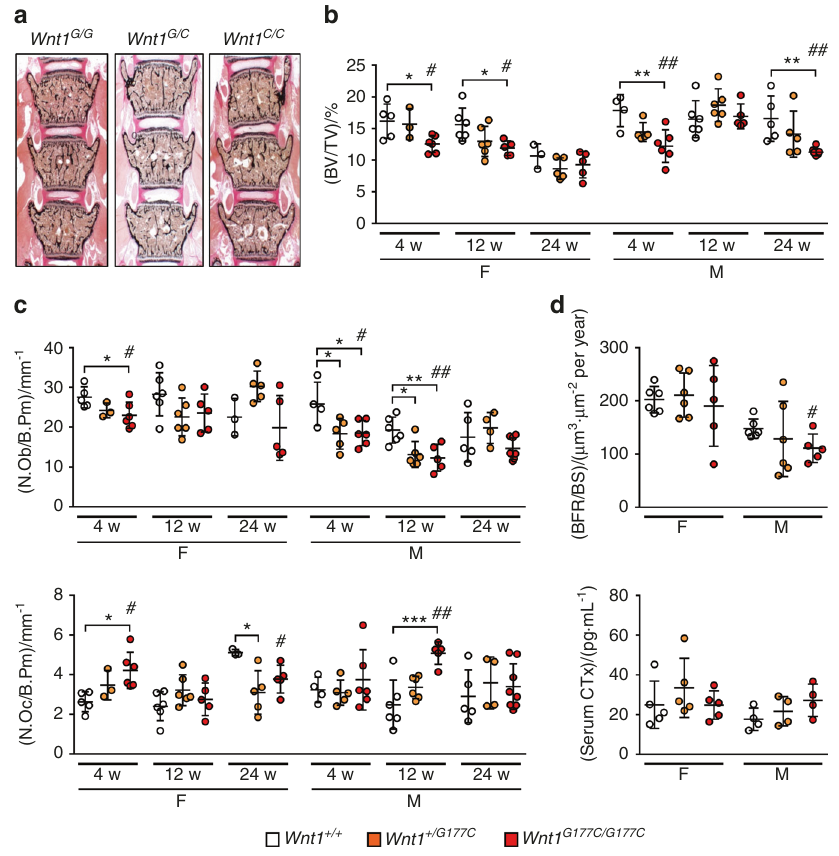
Fig. 3 Trabecular bone mass is only moderately affected in Wnt1 G177C/G177C mice. a Representative undecalci fi ed spine sections from 4-week-old male mice with the indicated genotypes ( Wnt1 G/G = Wnt1 + / + , Wnt1 G/C = Wnt1 + /G177C and Wnt1 C/C = Wnt1 G177C/G177C ) after von Kossa/van Gieson staining. b Quanti fi cation of the trabecular bone volume (BV/TV, bone volume per tissue volume) in female and male Wnt1 + / + , Wnt1 + /G177C , and Wnt1 G177C/G177C mice at 4, 12, and 24 weeks of age. c Quanti fi cation of the osteoblast (N.Ob/B.Pm, number of osteoblasts per bone perimeter) and osteoclast numbers (N.Oc/B.Pm, number of osteoclasts per bone perimeter) in the same groups of mice. d Quanti fi cation of the bone formation rate (BFR/BS, bone formation rate per bone surface) in the trabecular compartment of the lumbar spine (top) and serum crosslaps (CTx) levels (bottom) of male and female Wnt1 + / + , Wnt1 + /G177C and Wnt1 G177C/G177C mice at the age of 12 weeks. Data were analyzed by one-way ANOVA with Dunnett ’ s multiple comparison test (* P < 0.05, ** P < 0.01, *** P < 0.001) and Student ’ s t -test ( Wnt1 G177C/G177C vs. Wnt1 + / + , # P < 0.05, ## P < 0.01). Error bars indicate standard (Supplementary Fig. 4a), the PTH-responsive genes Cited1 and Tnsfsf11 (ref. 26 ) were induced to the same extent as in wild-type cultures (Supplementary Fig. 4b). Consistently, treatment of wild- type and Wnt1 G177C/G177C littermate mice by daily injection of PTH